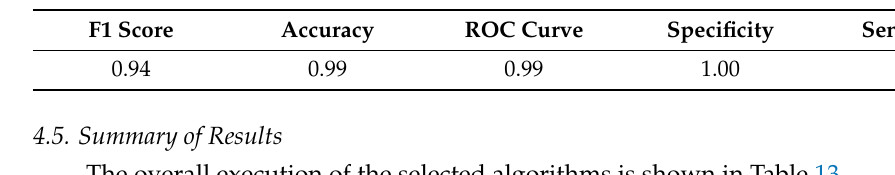
Table 12. Proposed isolation forest